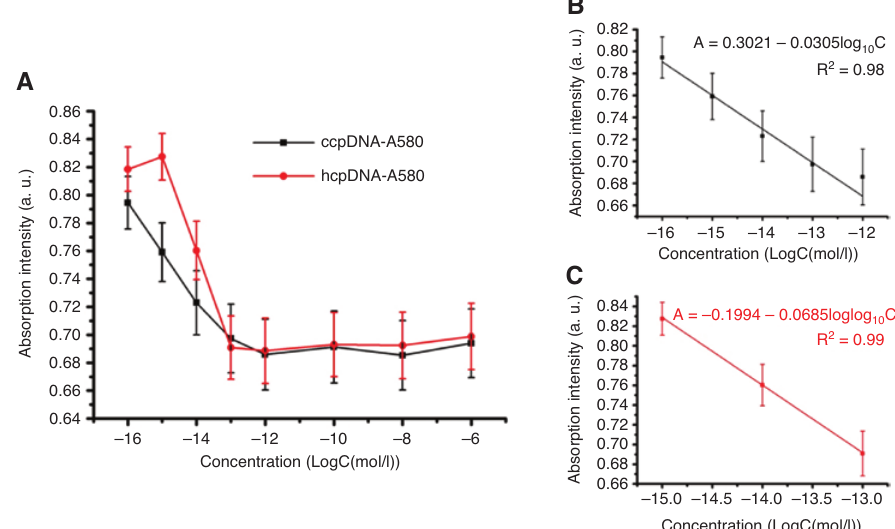
Figure 4: Quantitative test. (A) The intensity of the shoulder at 580 nm (A580) versus the tDNA concentration for ccpDNA-PEG-AuNPs (black dots) and hcpDNA-PEG- AuNPs (red dots). (B) and (C) The linear fit of the A580 versus the logarithmic concentration of tDNA (B) from 10 −15 to 10 −12 m for ccpDNA-PEG- AuNPs and (C) 10 −15 –10 −13 m for the hcpDNA-PEG-AuNPs. The error bars are calculated using the values of the absorption intensity between 578 and 582 nm (580 ± 2